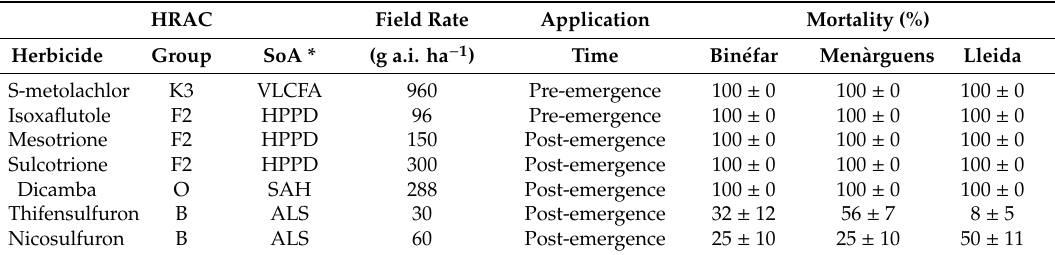
* Inhibit VLCFA (very long chain fatty acids) synthesis or HPPD (4-Hydroxyphenylpyruvate dioxygenase) and ALS (acetolactate synthase) enzymes; SAH for synthetic auxin